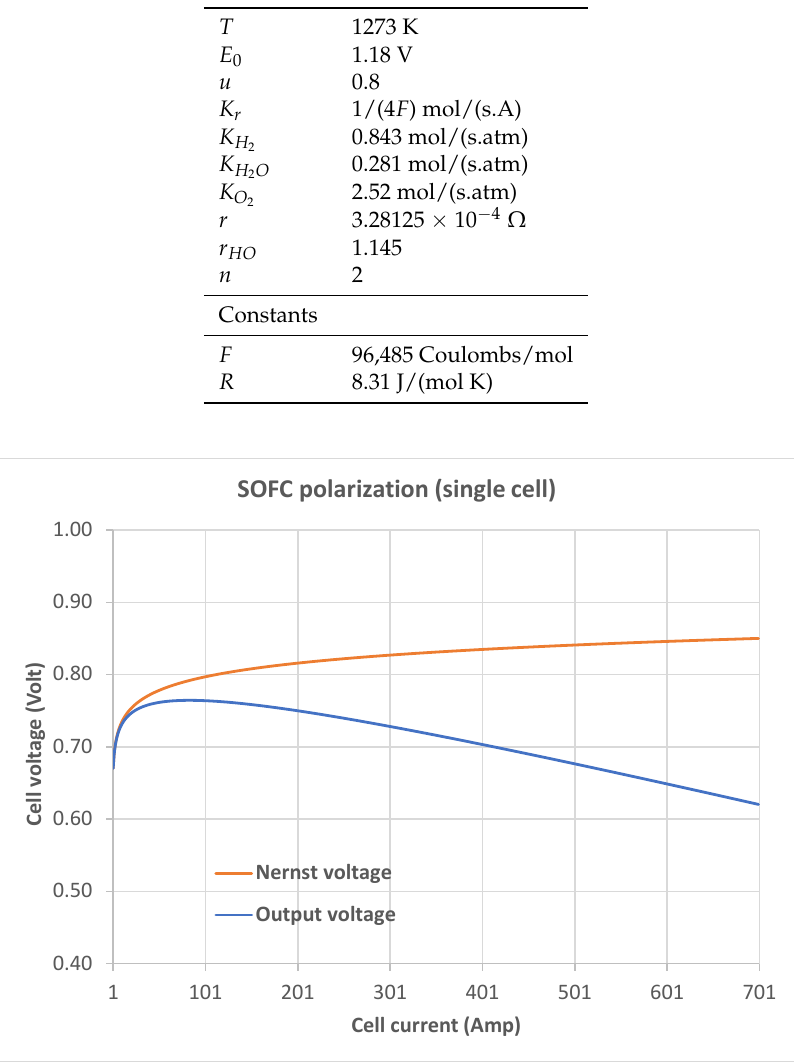
Figure 1. Solid oxide fuel cell (SOFC) polarization obtained with E Nernst given by Equation (8). Figure 1 has the horizontal (current) axis starting at 1 A, not zero, because in Equation (8), the Nernst voltage is undefined at I FC =